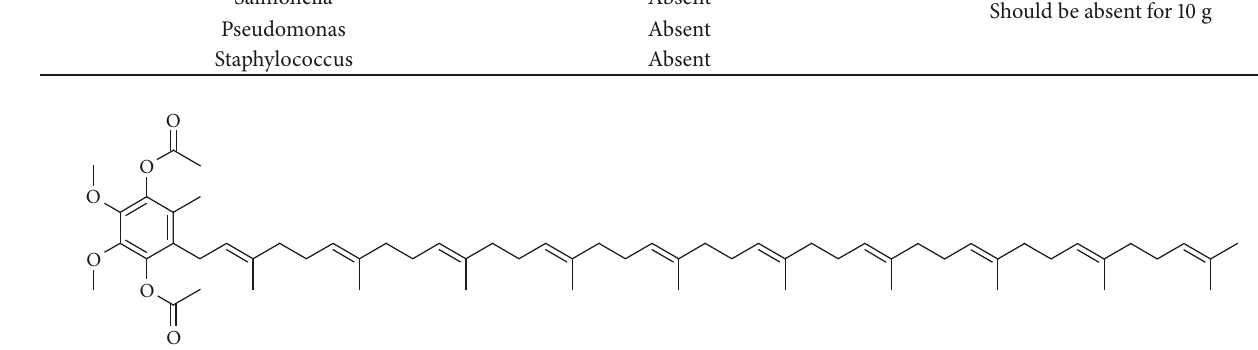
Figure 1: Structure of ubiquinol